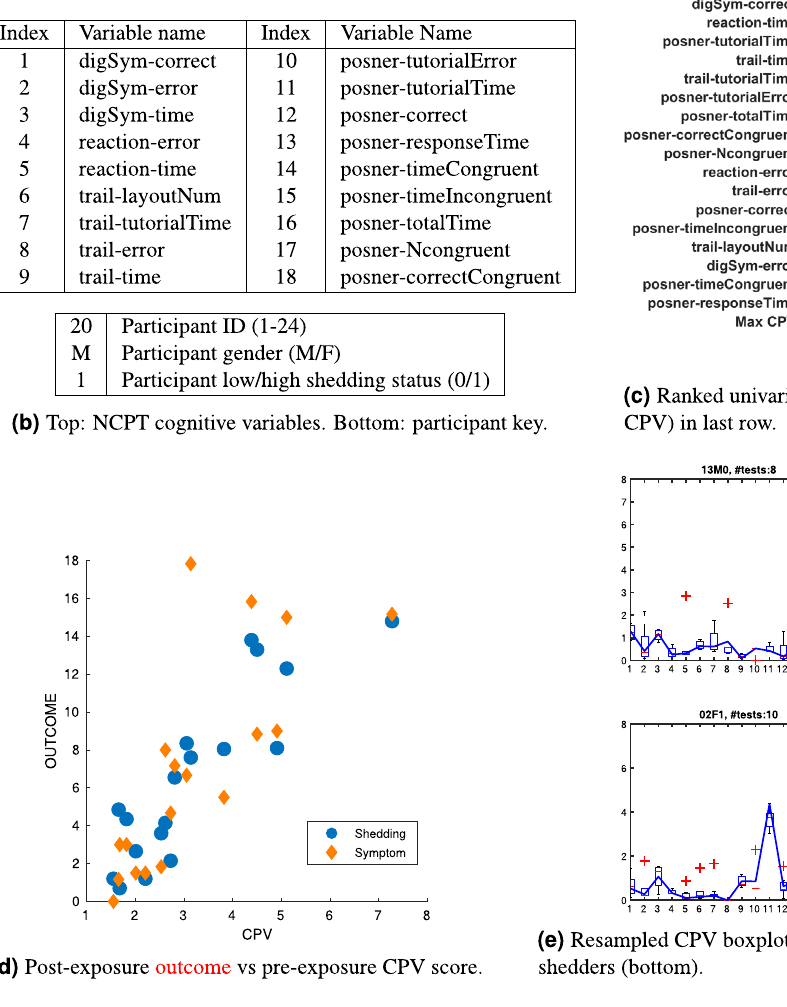
Figure 1. Pre-exposure cognitive performance variability (CPV) score is strongly associated with post-exposure outcome. ( a ) Challenge study layout showing baseline and post-inoculation biomarker sampling times for a study participant. ( b ) Definition of 18 NCPT variables measuring participant performance on 4 different tests: Digital Symbol Coding (DigSym), Go/No-Go (Reaction), Trail Making (Trail) and Attention Cuing (Posner). ( c ) Heatmap of univariate CPV scores for each study participant. participants are ordered from left to right in terms of decreasing amounts of post-exposure shedding. NCPT measures are ordered from top to bottom in terms of decreasing CPV max value over the participants. ( d ) Scatterplot of CPV and outcome for the 18 participants. Shedding (log 10 TCID 50 /ml) and symptom (modified Jackson score) are aggregated over the full post-exposure period of the study. ( e ) Boxplots of the resampled univariate CPV scores, computed by successively leaving out a session, over the 18 NCPT variables in Fig. 1b for two of the lowest shedding (top row) and two of the highest shedding (bottom row) challenge study participants. Solid blue curve indicates the CPV scores shown in heatmap ( c